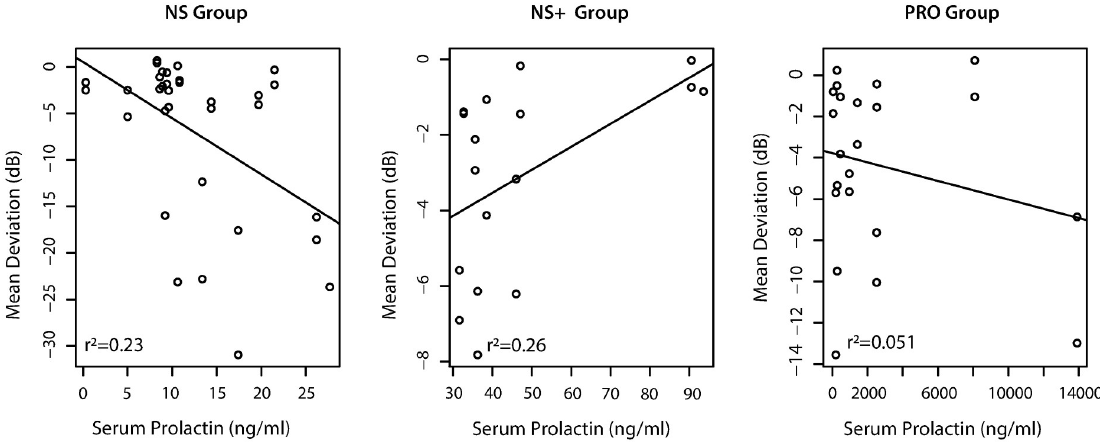
Fig 3. Pearson linear regression analysis was performed for all subjects with the controls divided by subgroups (NS+ and NS). Analysis of PRL as a function of mean deviation in the PRO group revealed little negative association (R = -0.23, p-value = 0.31). When analyzing the controls by subgroups, NS+ demonstrated a significant correlation between mean deviation and serum PRL level (R = 0.51, p-value = 0.035) while the NS group demonstrated an inverse correlation that approached significance (R = -0.47, p-value = 0.0053).